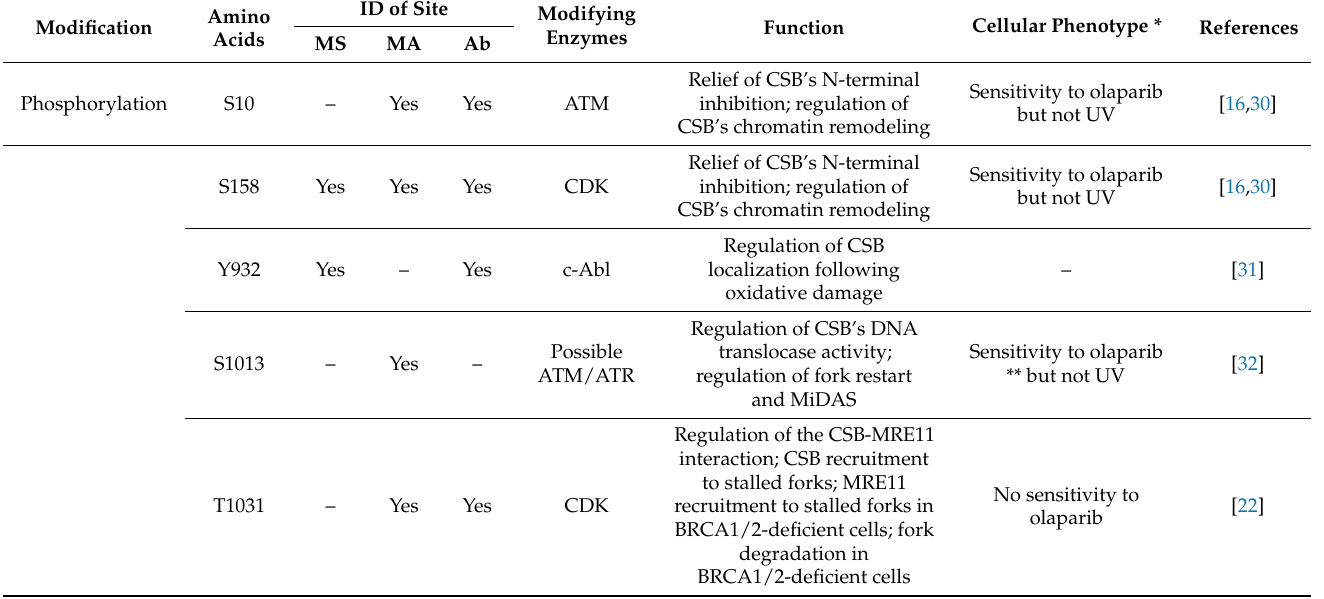
Table 1. Summary of post-translational modifications of